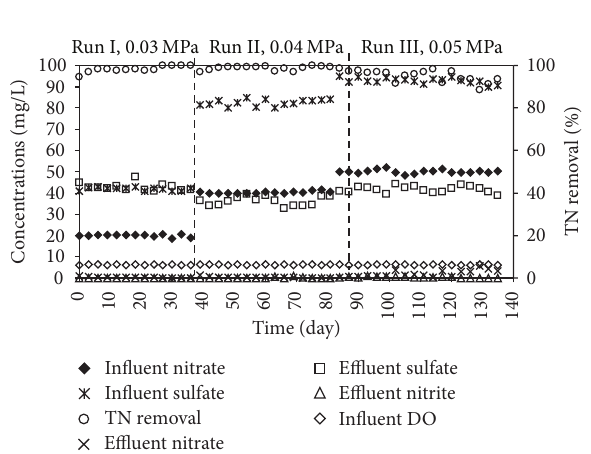
Figure 2: The nitrate, nitrite, sulfate, DO, and TN removal in the continuous experiments.